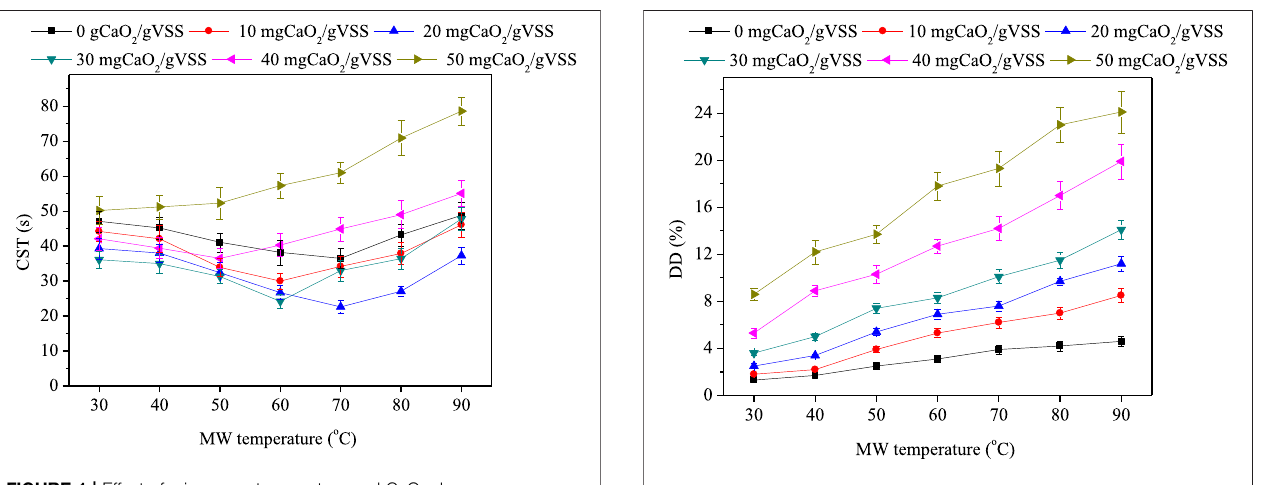
FIGURE 2 | Effect of microwave temperature and CaO 2 dosages on sludge disintegration degree.